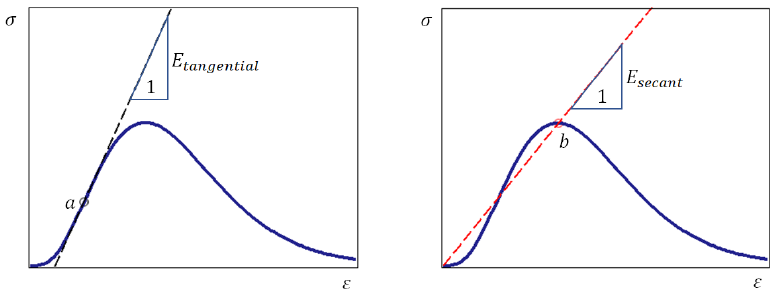
Figure 3. The line 𝜎 = 𝜀𝐸 (cid:3047)(cid:3028)(cid:3041)(cid:3034)(cid:3032)(cid:3041)(cid:3047)(cid:3036)(cid:3028)(cid:3039) passes through the inflection point a, the coordinates of which Figure 3. The line σ = ε E tangential passes through the inflection point a, the coordinates of which can can be found from the equation 𝑑 (cid:2870) 𝜎/𝑑𝜀 (cid:2870) = 0 . The line 𝜎 = 𝜀𝐸 (cid:3046)(cid:3032)(cid:3030)(cid:3028)(cid:3041)(cid:3047) _secant passes through the be found from the equation d 2 σ / d ε 2 = 0. The line σ = ε E secant _secant passes through the origin and origin and point 𝑏 , where 𝜀 = 𝜀 (cid:3043)(cid:3032)(cid:3028)(cid:3038) , 𝜎 = 𝜎 (cid:3043)(cid:3032)(cid:3028)(cid:3038) and 𝑑𝜎/𝑑𝜀 = 0 . point b , where ε = ε peak , σ = σ peak and d σ / d ε =